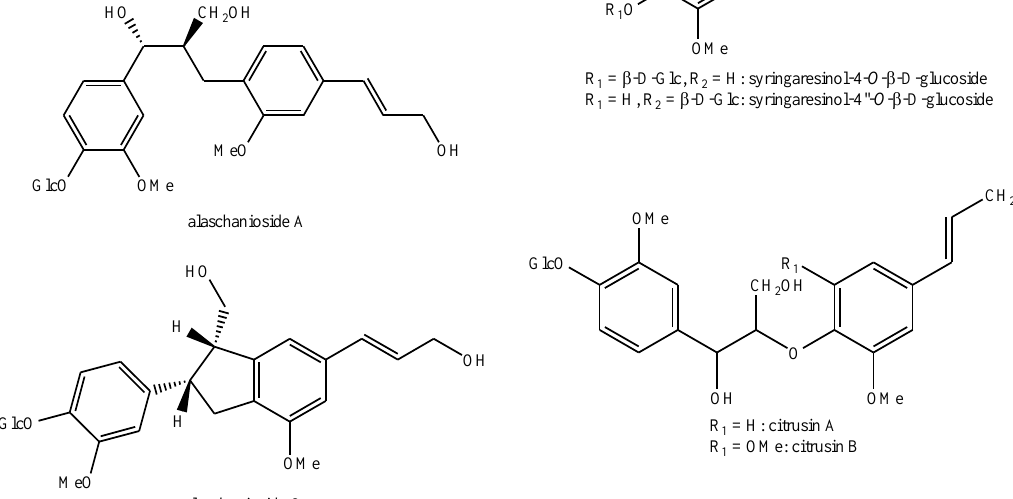
Figure 9. Lignans and neo -lignans identified in Pedicularis species—part 3. Plants 2019 , 8 , x FOR PEER REVIEW